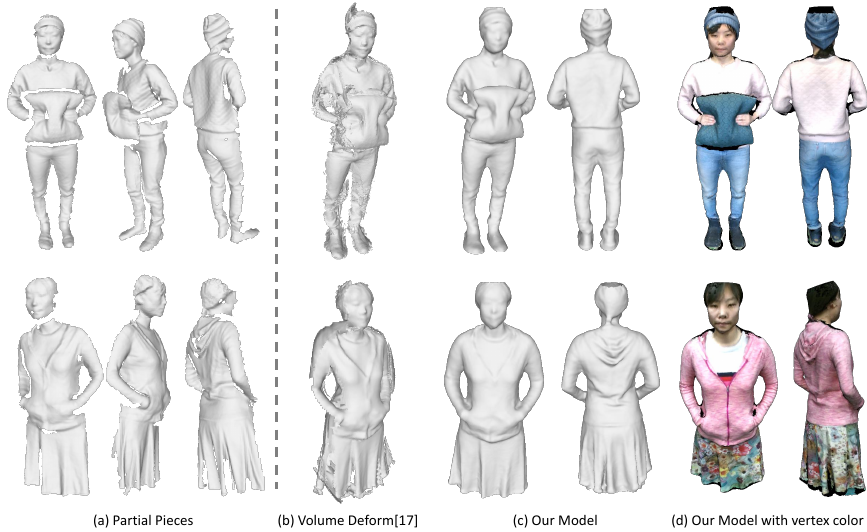
Figure 12. Qualitative evaluation on full body models. ( a ) some sampled partial pieces; ( b ) the results from VolumeDeform [17]; ( c ) the complete models we get with our approach; ( d ) our recovered colored models.